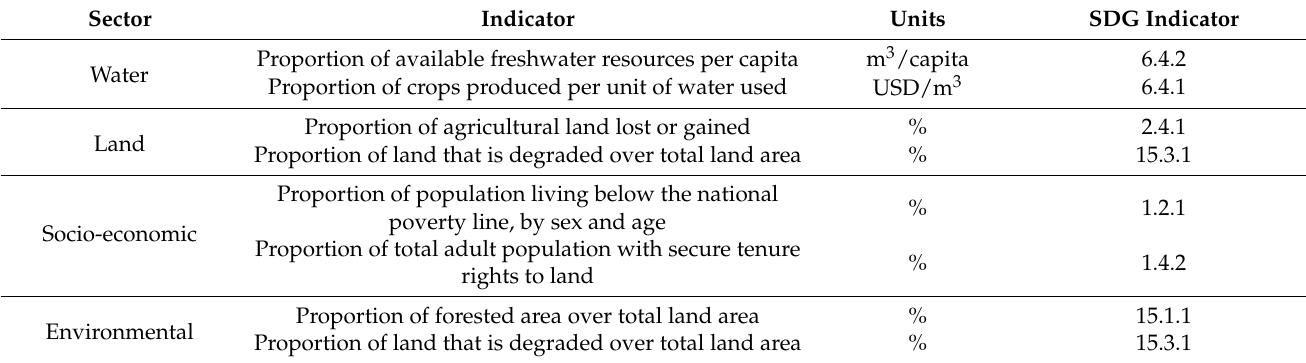
Table 1. Sustainability indicators for assessing, monitoring, and evaluating land reform